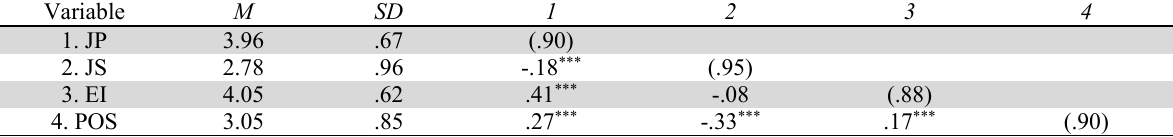
Descriptive statistics, Cronbach’s Alpha Coefficients, and Correlations among Study Variables Variable